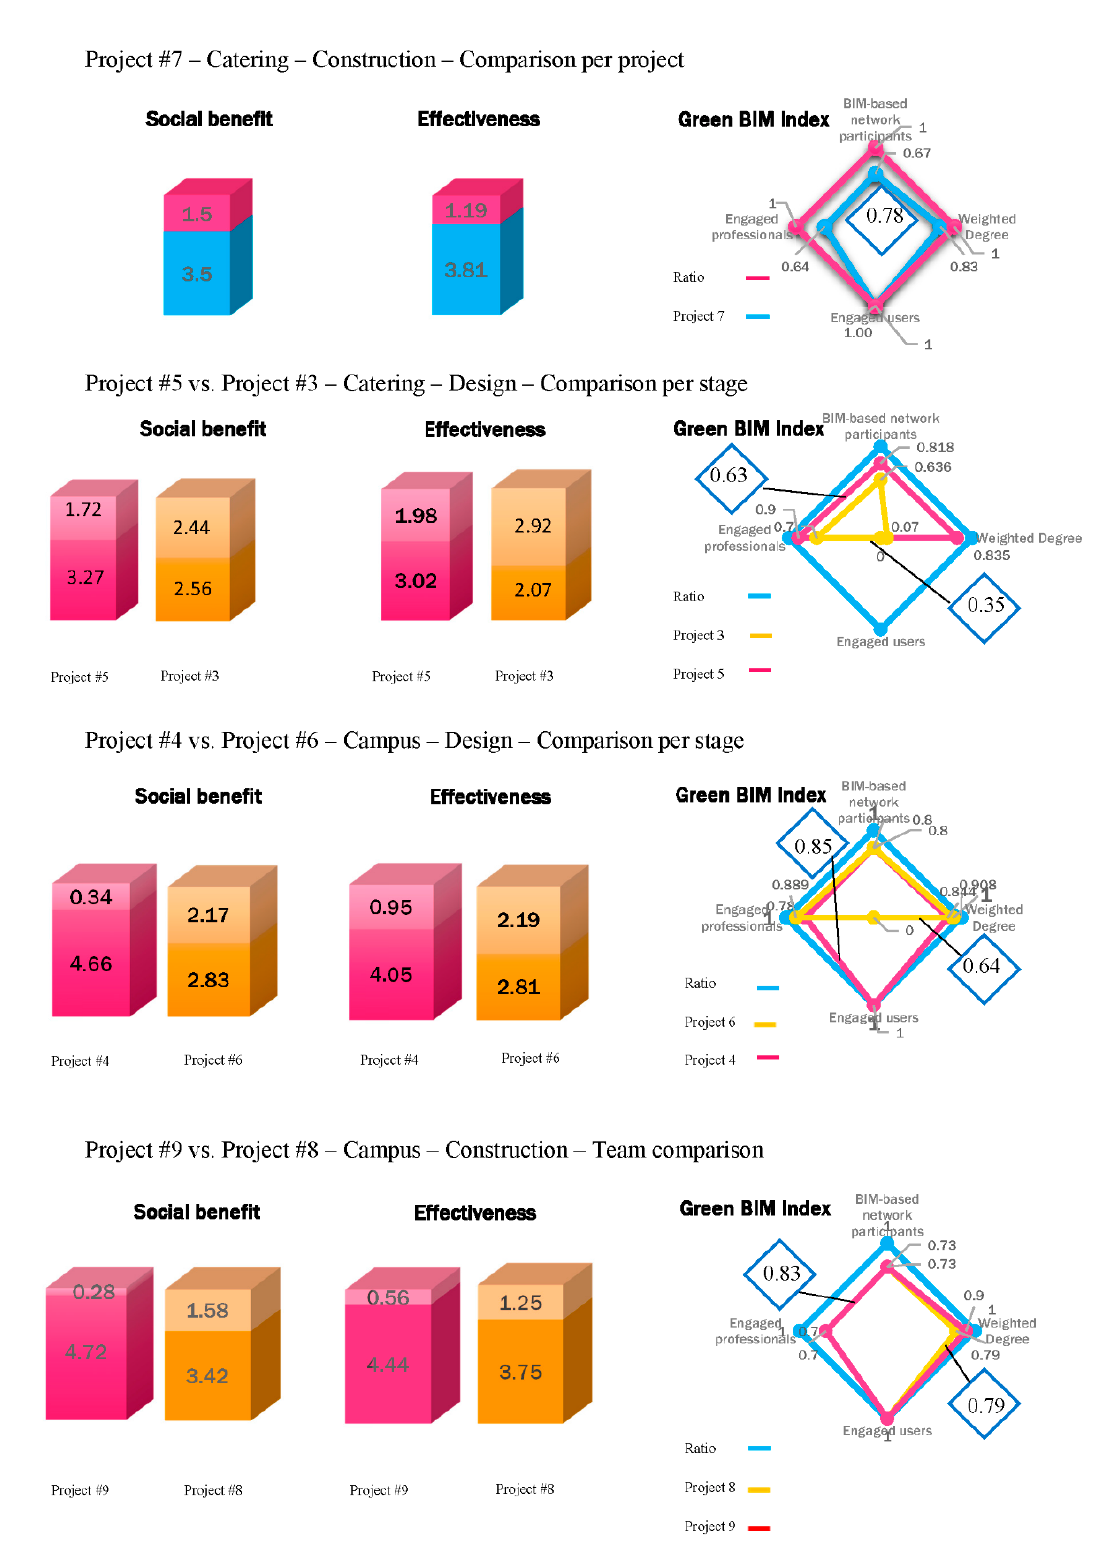
Figure 4. Comparison of evaluations and index findings for projects by stages and teams.